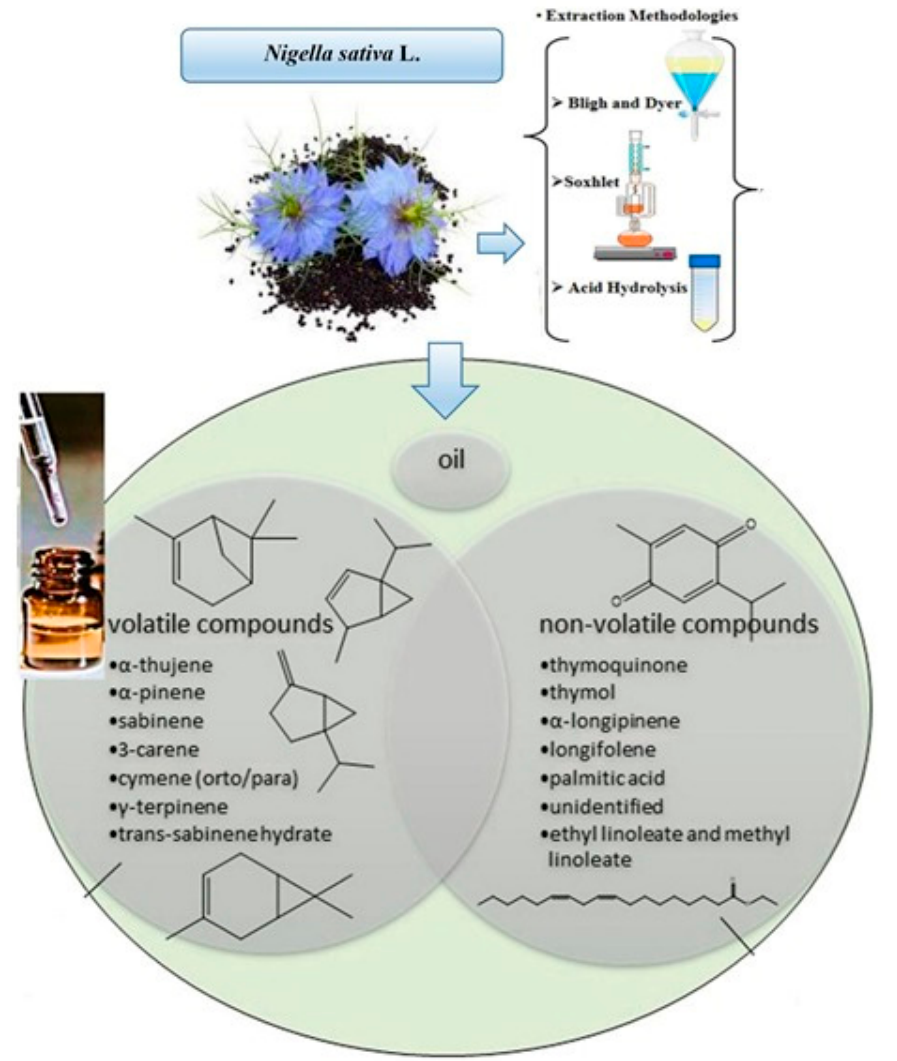
Figure 1. Nigella sativa oil extraction and its chemical composition.